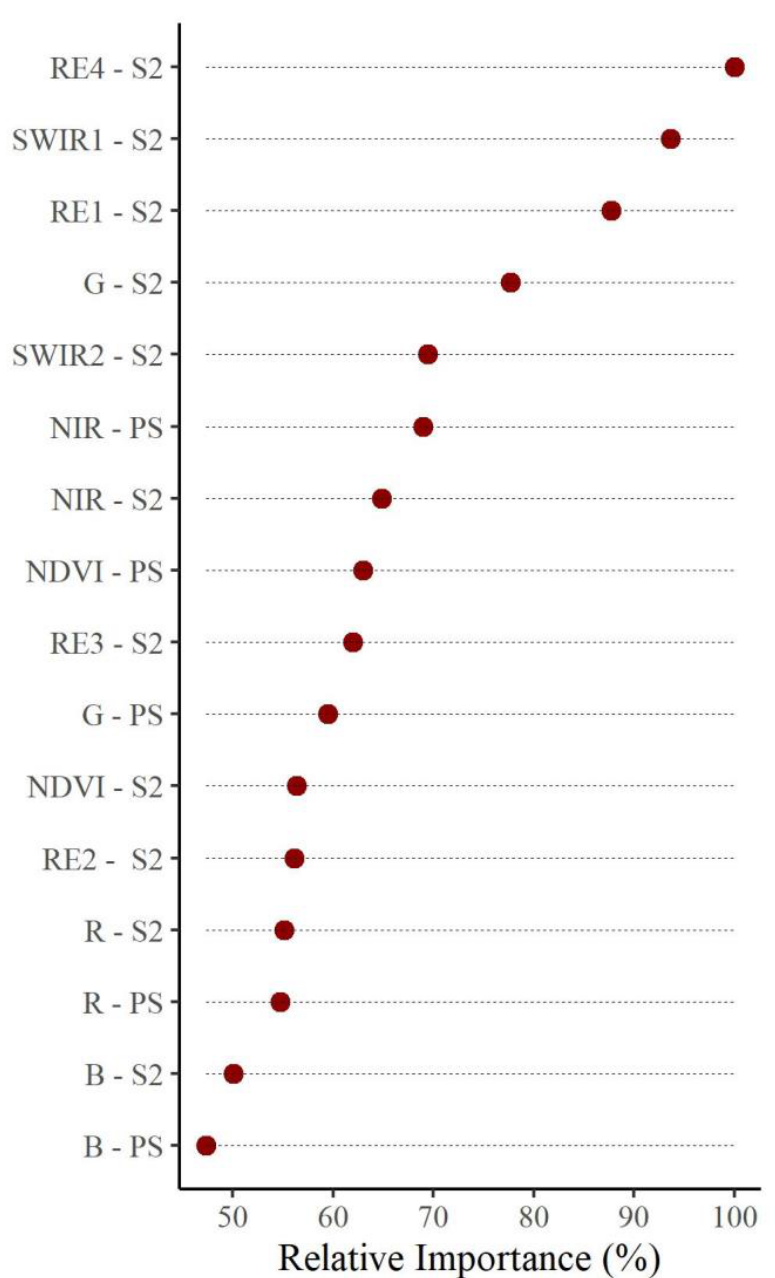
Figure 5. The relative importance of the predictor variables was measured by the variable importance metric in the eighteen RF-based imputation models using both PlanetScope and Sentinel-2 data. The NDVI images calculated using the imputed R and NIR spectral bands and the NDVI images predicted directly by the RF-based imputation models showed the same spatial agreement with the original UAV NDVI images in the three levels of missing parts (Table 3). Figure 7 also shows the high spatial agreement between the original UAV NDVI image and the predicted and calculated NDVI image, highlighting the potential of the imputed spectral bands to further derive other vegetation